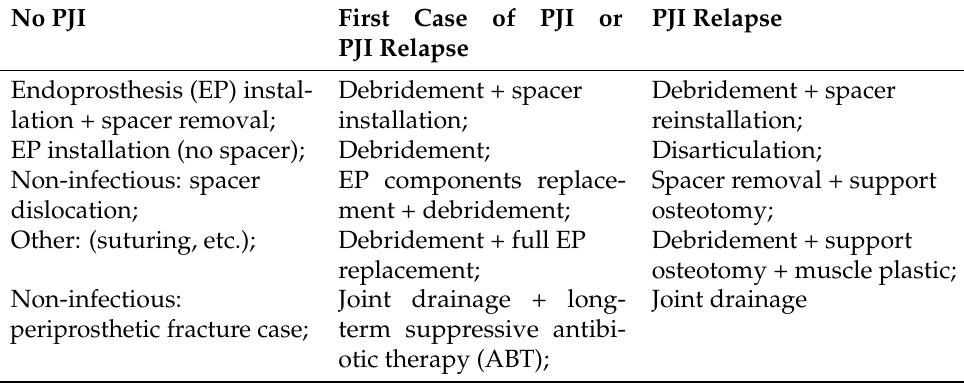
Table 3. Operations performed and their relation to